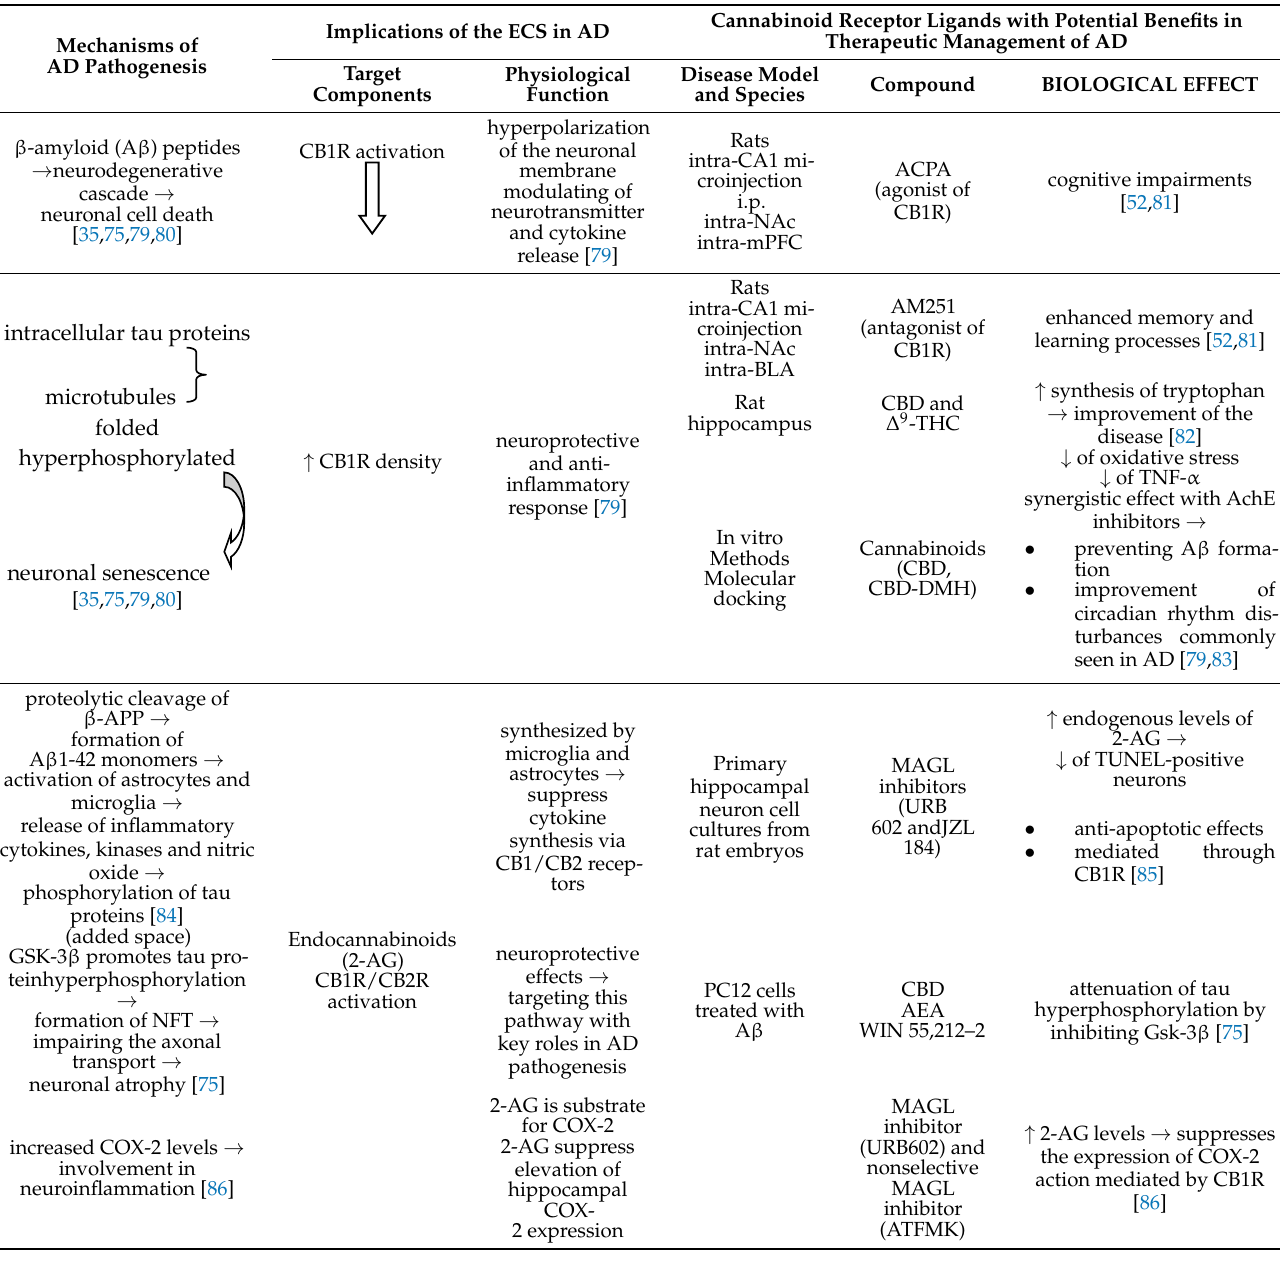
Table 1. Involvement of ECS in various pathological aspects of AD.